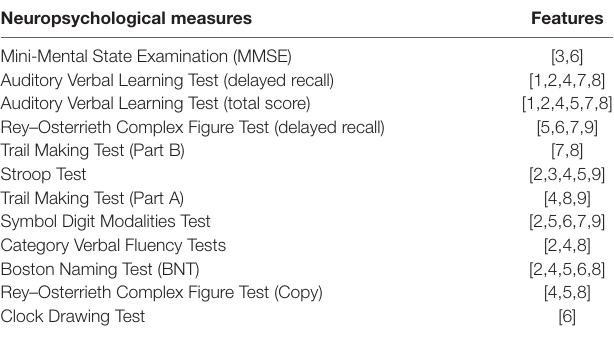
TABLE 2 | The input features of optimal models in support vector